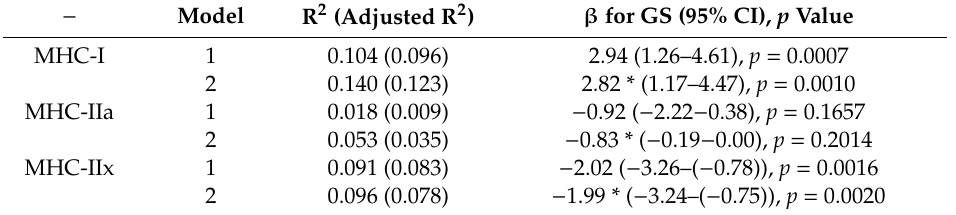
Model1: genotypescore,Model2: genotypescoreandage. GS:genotypescore,CI:confidenceinterval; *age-adjusted regression coe ffi cients for Model 1: genotype score, Model 2: genotype score and age. GS: genotype score, CI: confidence interval; * age-adjusted regression coefficients for GS.